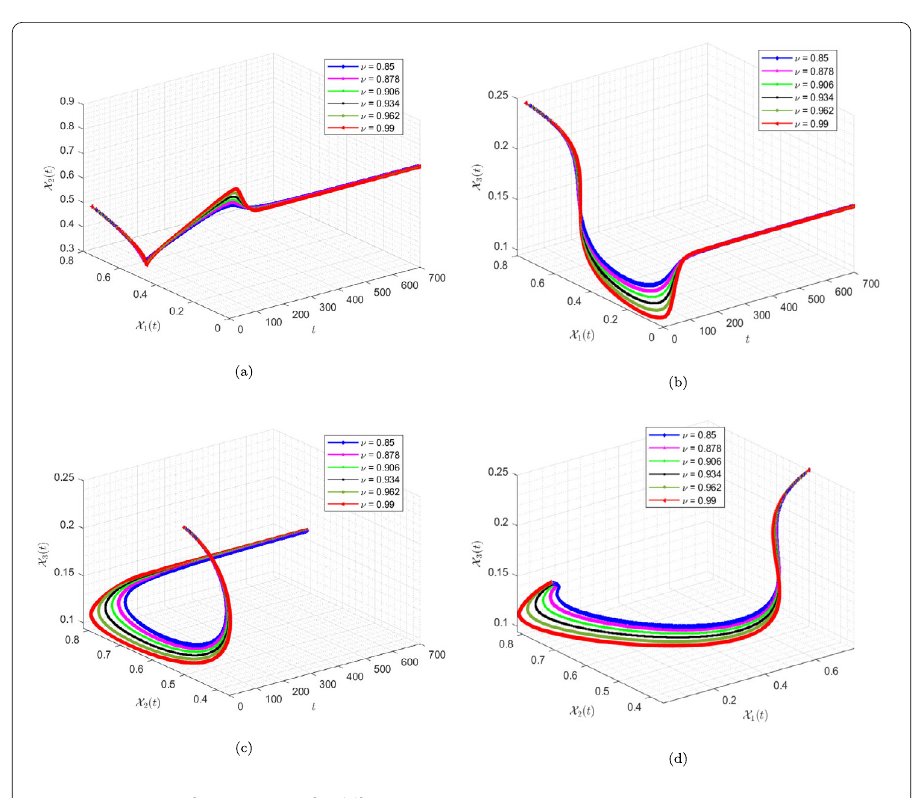
Figure 6 Dynamics for system (19) for different parameters in Set3